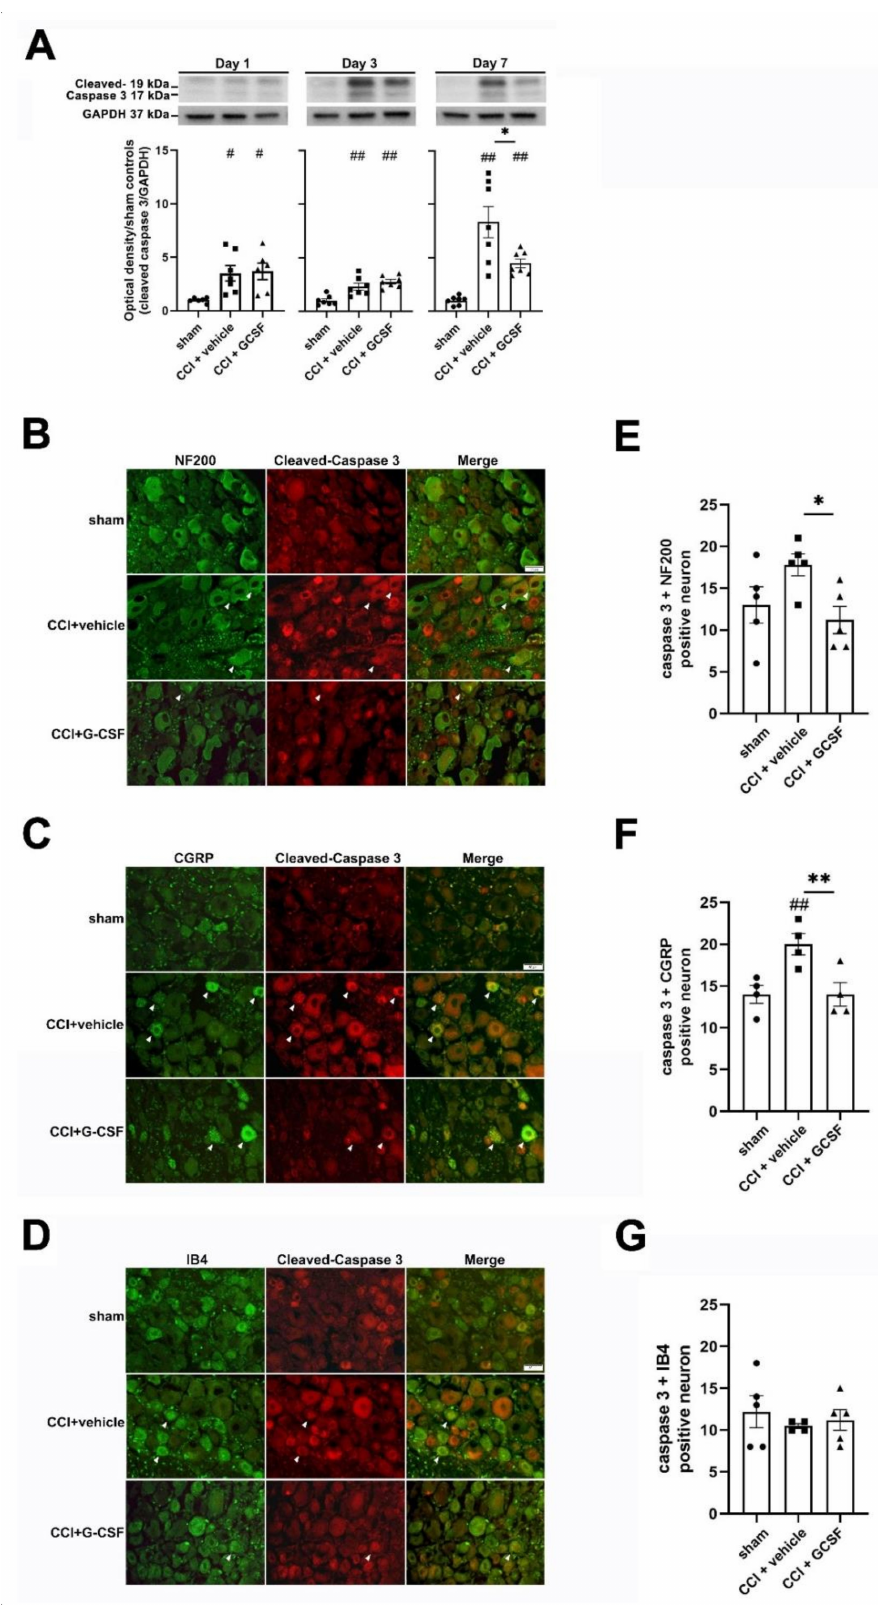
Figure 6. G-CSF downregulated cleaved caspase-3 (apoptotic) protein levels in dorsal root ganglia neurons on the 7th day after nerve injury. ( A ) Western blot analysis revealed significantly